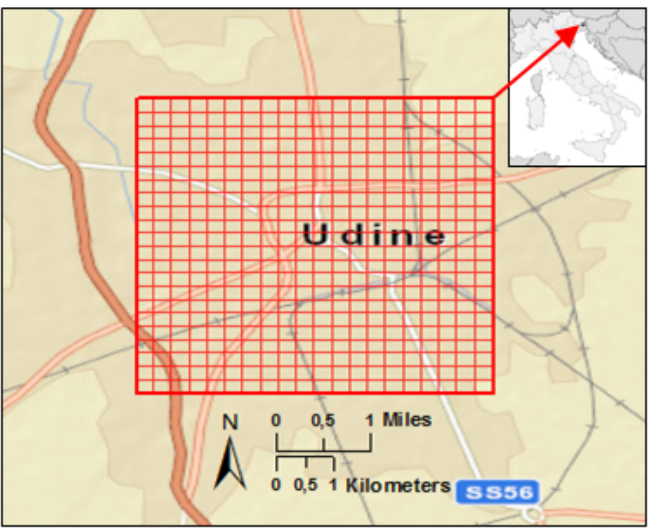
Figure 1. Study area: the urban environment of the city of Udine, Friuli Venetia Giulia Region, Italy; the red grid indicates the spatial resolution as 250 m × 250 m ‘pixels’ of the mobile network